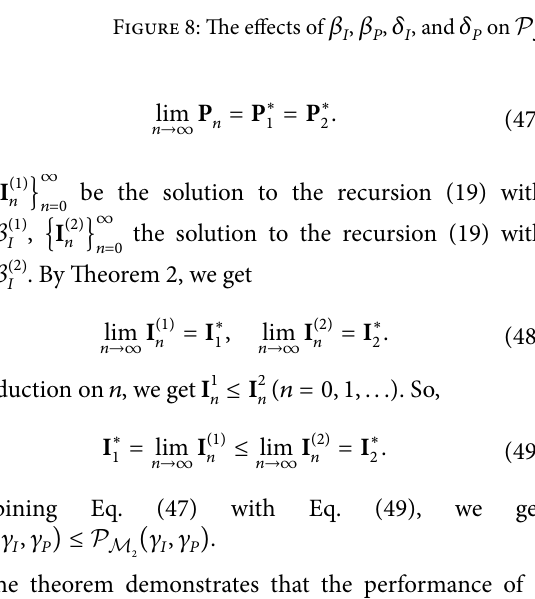
Figure 8: The effects of